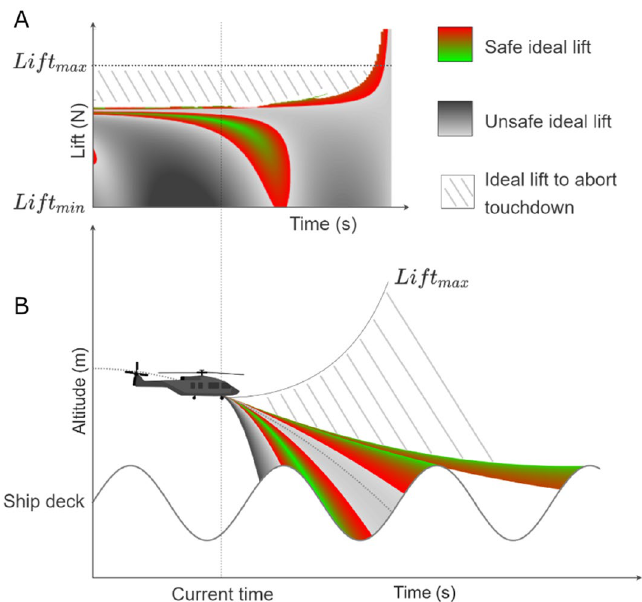
Figure 1. Numerical simulation of the consequences of the time-dynamics of the affordance of deck-landing- ability on ( A ) the future velocity at touchdown ( V td ) depending on the applied lift (where Lift min is the minimum lift a helicopter can reach and Lift max is the maximum lift pulling the helicopter upward), and on ( B ) the helicopter’s trajectory relative to the ship’s deck. ( A ) The applied lift can belong to three areas in the figure. When located in the white area, it rules out landing on the ship (i.e., no deck-landing should be attempted) and it is recommended to abort the deck-landing maneuver. When the lift corresponds to the colored areas, it corresponds to ideal lift values compatible with landing with V td < V crt (i.e., with safe deck-landing). Green to red colors encode the distance from V td to V crt . Several colored areas are presented here over time, as successive ship’s heave movements may give other possibilities for landing with V td < V crt . When the lift is located in gray areas, it leads to land with V td > V crt (i.e., unsafe deck-landing). White areas show lift which lead to avoid any contact with the deck. The bottom panel shows the corresponding helicopter trajectories relative to the ship deck’s vertical heave in the case of the three scenarios.